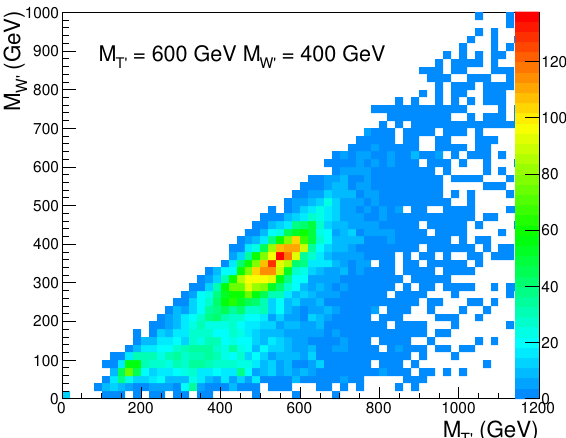
Figure 8 . Reconstructed signal distributions for M T 0 = 600 GeV, M W 0 = 400 GeV (littlest Higgs model) together with the expected background processes corresponding to an intergrated luminosity of 50 fb − 1 at 13